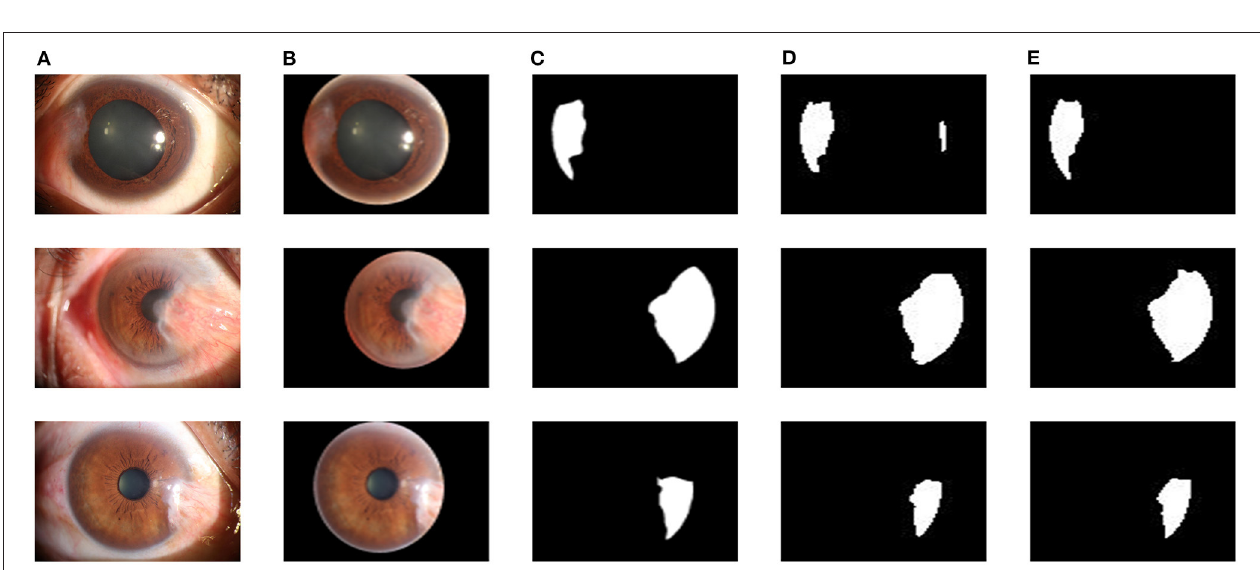
FIGURE 9 | Segmentation results of two models: (A) The original anterior segment images. (B) The cornea images output by the cornea segmentation module. (C) Ground truth. (D) The segmentation results of the U-Net++ model. (E) The segmentation results of the improved U-Net++ model.